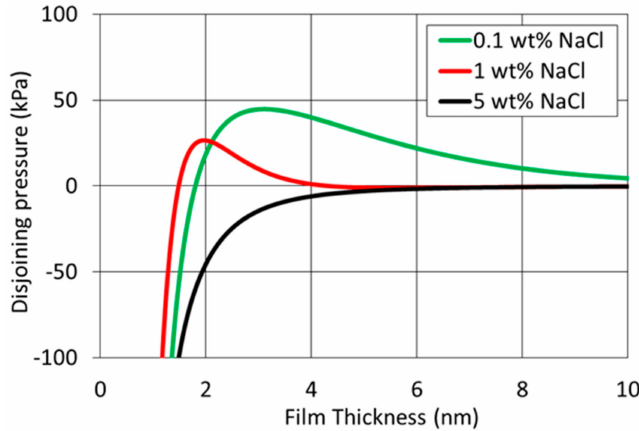
Figure 4. Total disjoining pressure, under constant reduced potential, versus interfacial separation of kaolinite and Oil A with presence of various concentration of